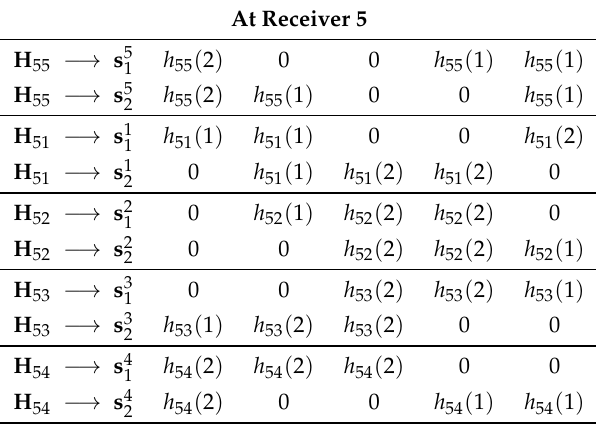
Table 3. Antenna switching pattern for receiver